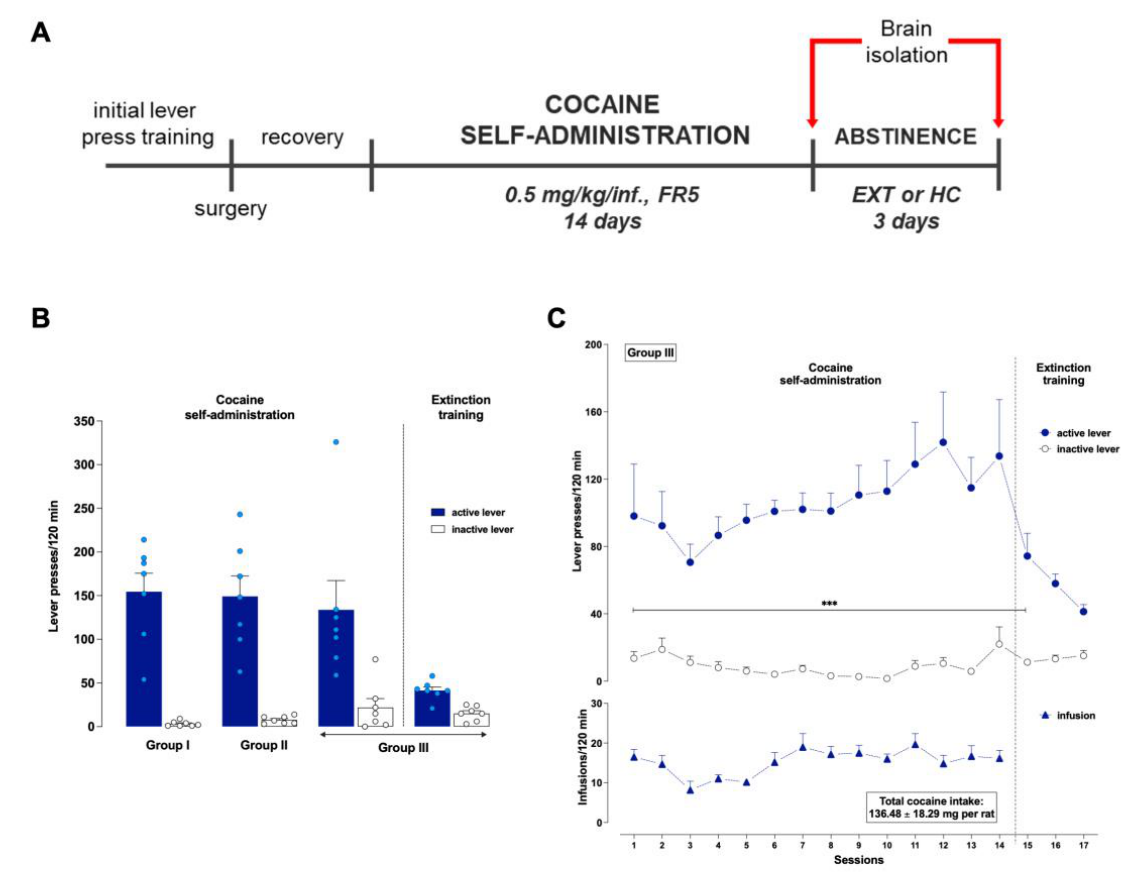
Figure 1. ( A ) Study design and timeline. Male rats were assessed for 14 days of intravenous cocaine self-administration. The molecular experiments after cocaine self-administration and a 3-day drug- free period with extinction training or in a home cage isolation were evaluated in the selected rat brain regions. EXT: extinction training; FR: fixed ratio; HC: cocaine abstinence in the home cage. ( B ) The average number of presses on the active and inactive lever during the last day (14th session) of cocaine self-administration and the extinction training procedure in individual experimental groups. Group I: rats whose brains were collected immediately after the last self-administration session. Group II: rats whose brains were collected after the self-administration period and 3 days of abstinence in the home cage. Group III: rats whose brains were collected after the self-administration period and 3 days of extinction training. n = 7 rats per experimental group. ( C ) Representative graph of behavioral responses of male rats under cocaine self-administration and early extinction training (Group III). Numbers of active (blue dots) and inactive (white dots) lever presses and infusions (blue triangle) during the 14 sessions of cocaine (0.5 mg/kg/infusion) self-administration under stable schedules of reinforcement (FR5) and 3 days of extinction training. Data were analyzed by a two-way ANOVA for repeated measures and the post hoc Newman–Keuls test. n = 7 rats per experimental group. *** p < 0.001 versus the active lever presses. The data are expressed as the mean ( ±